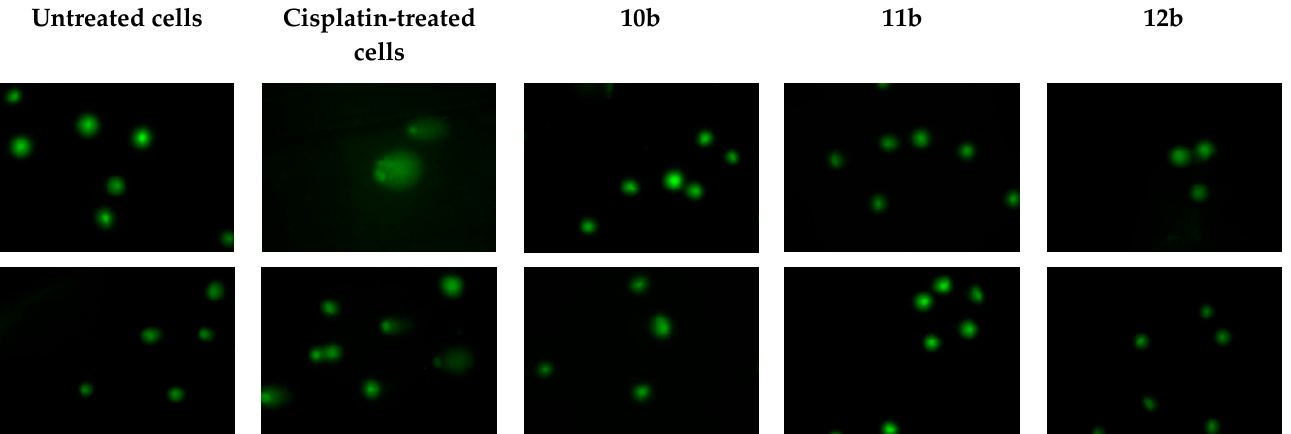
Figure 5. Genotoxicity evaluation of the thiadiazoles 10a – 12b in Hs27 cells. The investigated compounds were tested at their CC 30 concentrations. Cisplatin (positive control) was tested at 10 µg/mL.